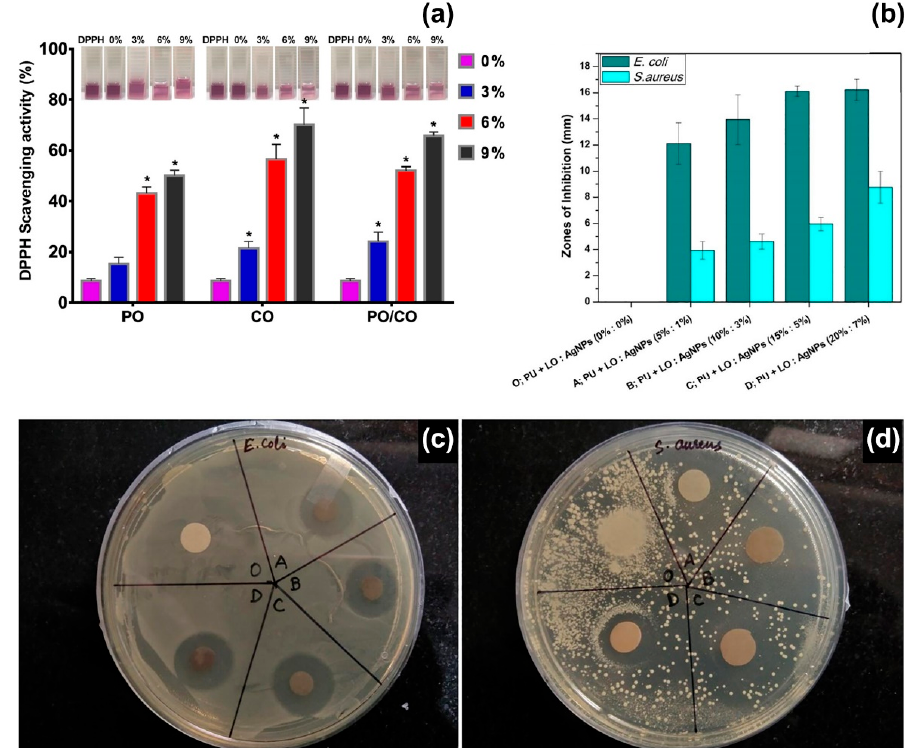
Figure 3. ( a ) 2,2-Diphenyl-1-picryl-hydrazyl-hydrate (DPPH) radical scavenging activity of